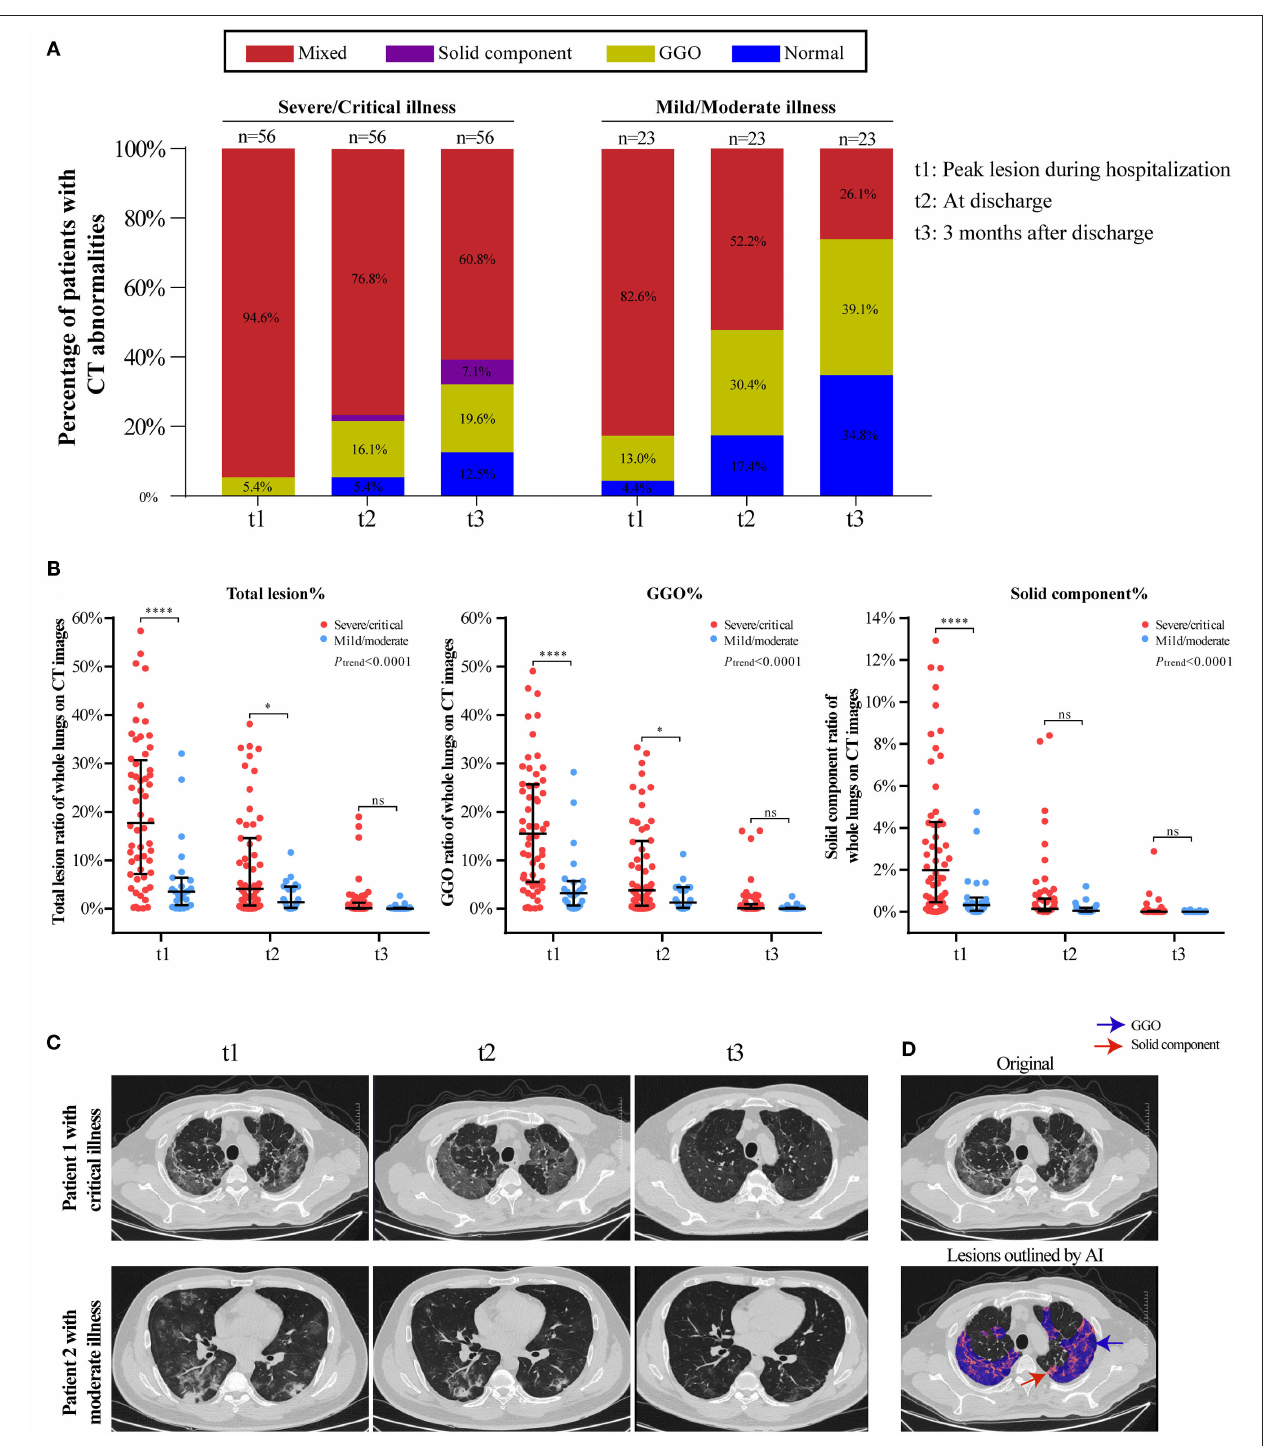
FIGURE 2 | Temporal changes of CT findings in 56 severe/critical RPs and 23 mild/moderate RPs from hospitalization to 3 months after discharge. (A) The distribution of the main patterns of chest CT abnormalities at three time points (t1: peak lesion during hospitalization, t2: at discharge, t3: 3 months after discharge) among severe/critical and mild/moderate RPs. Staked-bar graphs show the proportion of patients with GGO/solid component/mixed lesions on CT images. (B) The ratio of total lesion, GGO and solid components in the whole lungs at three time points. Linear mixed model (LMM) was applied for comparing the change trend of lesion ratio between severe/critical RPs and mild/moderate RPs, and the statistical difference was indicated by Ptrend. The comparison of lesion ratio between two